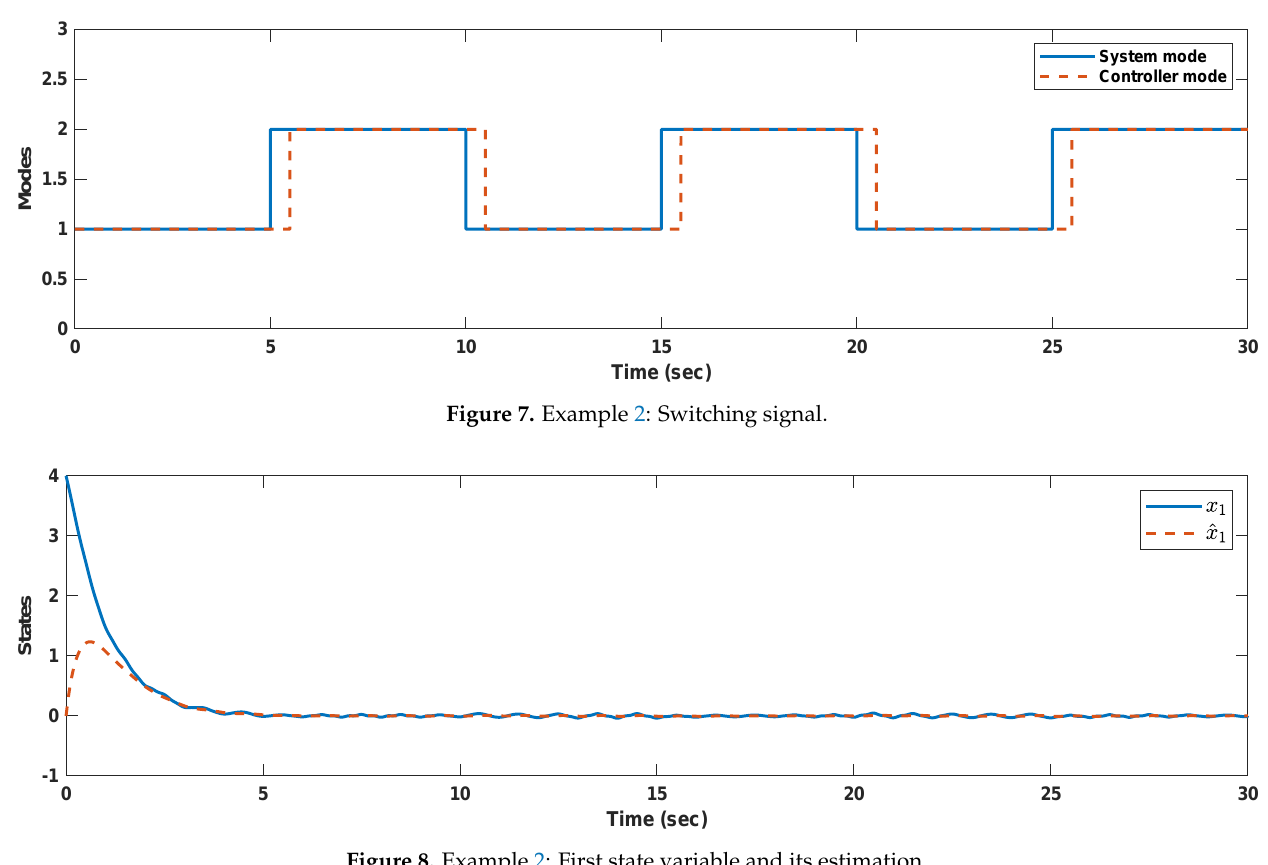
Figure 8. Example 2: First state variable and its